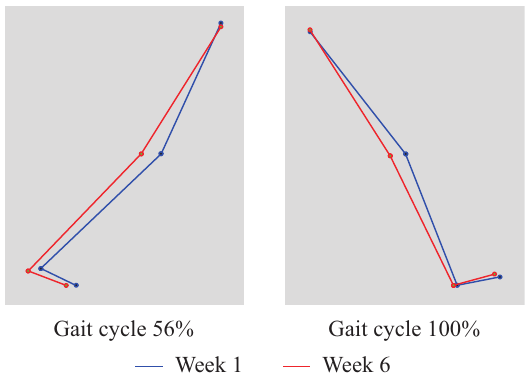
Figure 13. Comparison of the typical motions of the POFF condition around the timings of the toe off and the heel contact between Week 1 and Week